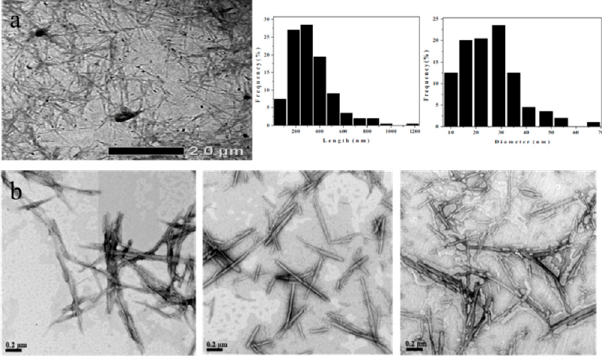
Figure 6. TEM image of rod-like CNC from bacterial cellulose, ( a ) particle size distribution. Reprinted with permission from Ref. [93]. ( b )TEM micrographs of the BCNC prepared by different acid hydrolyses: HCl, H 2 SO 4 , HCl + H 2 SO 4, . Reprinted with permission from Ref. [66]. Copyright 2015 Elsevier and 2018 American Chemical Society.